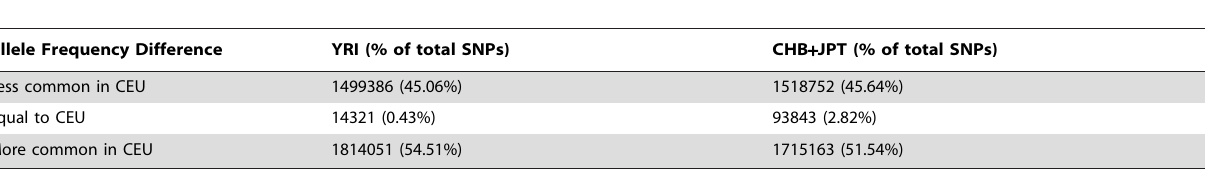
Table 2. Number of SNPs with higher or lower minor allele frequency in YRI or CHB + JPT, as compared to CEU in Pilot 1 of 1000